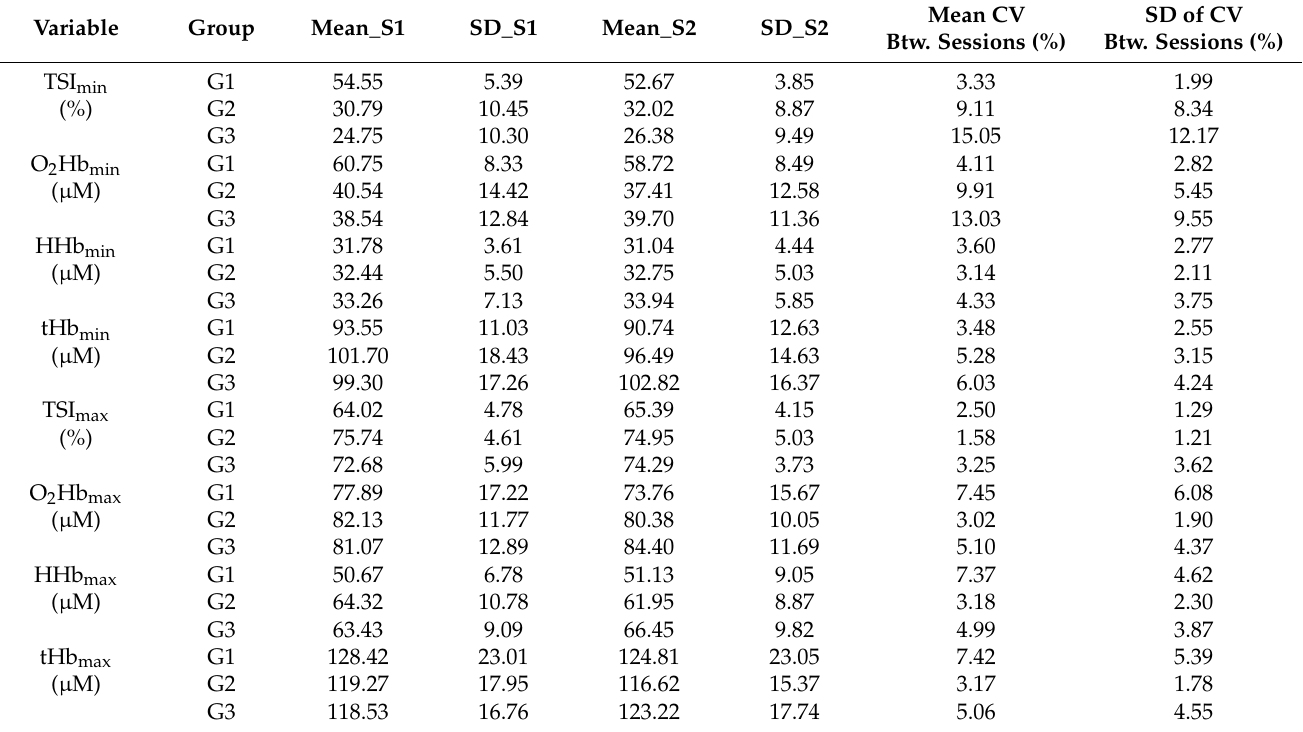
Table 9. Between-session variability for minimums and maximums.